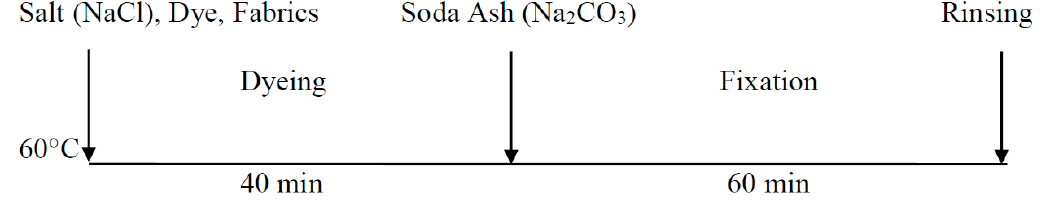
Figure 1. The dyeing profile of water ‐ based dyeing.